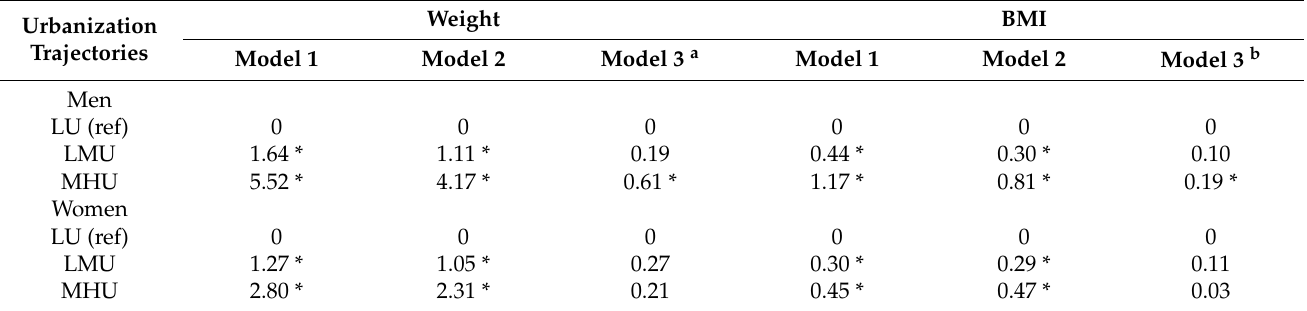
Table 2. Multilevel mixed regression estimates, examining weight and BMI by